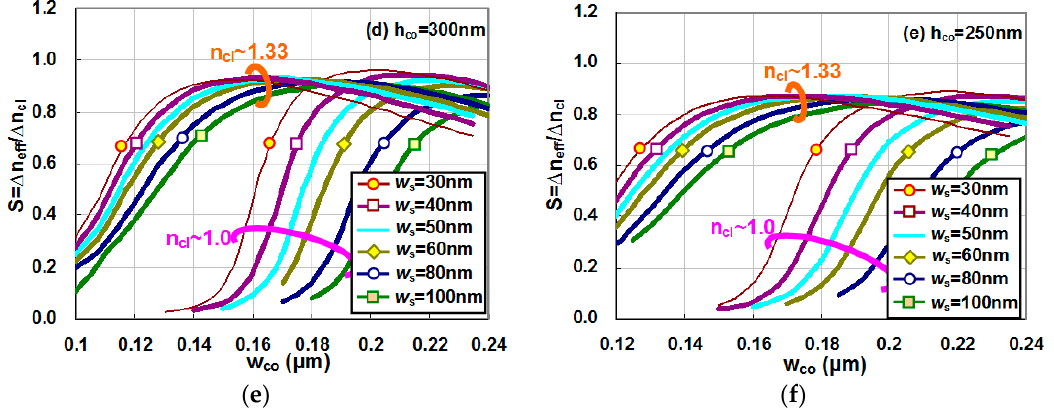
Figure 2. ( a ) The cross section of a nanoslot optical waveguide; and ( b ) the calculated field distribution of the TE fundamental mode for a SOI nanoslot waveguide with h co = 400 nm, w co = 180 nm, and w s = 30 nm as an example. The calculated sensitivity for gas sensing and liquid sensing as the core width varies for the cases with different core heights: ( c ) h co = 400 nm; ( d ) h co = 350 nm; ( e ) h co = 300 nm; and ( f ) h co = 250 nm.